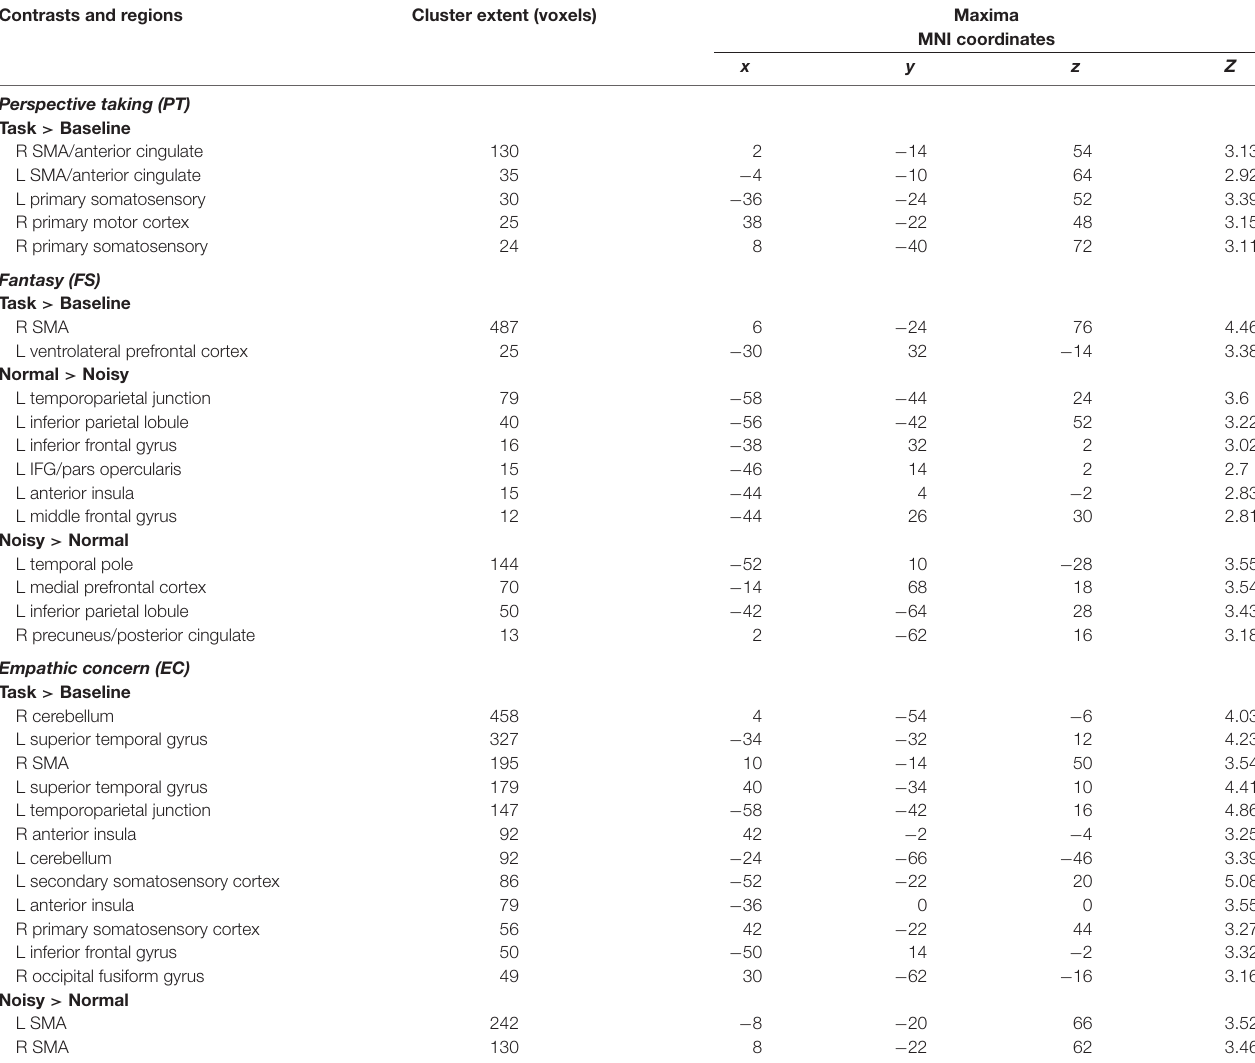
TABLE 1 | Experiment 1 results by interpersonal reactivity index (IRI) subscale. Contrasts and